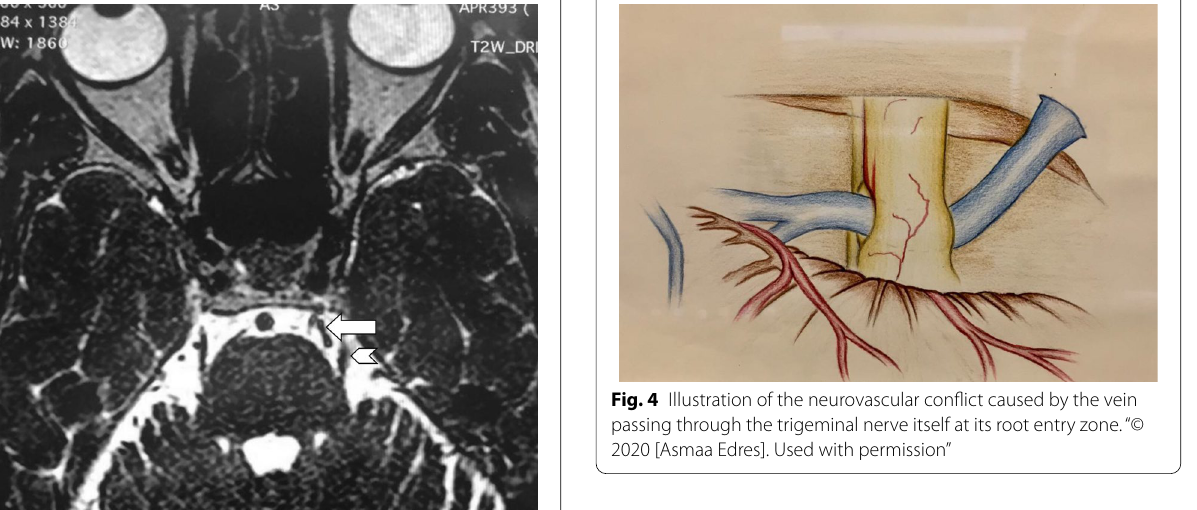
offending vessel as a Tributary of the petrosal vein pass- ing through the trigeminal nerve itself. Microvascu- lar decompression was performed by coagulating the offending vein and dividing it proximal to the root entry zone of the trigeminal nerve followed by placing pieces